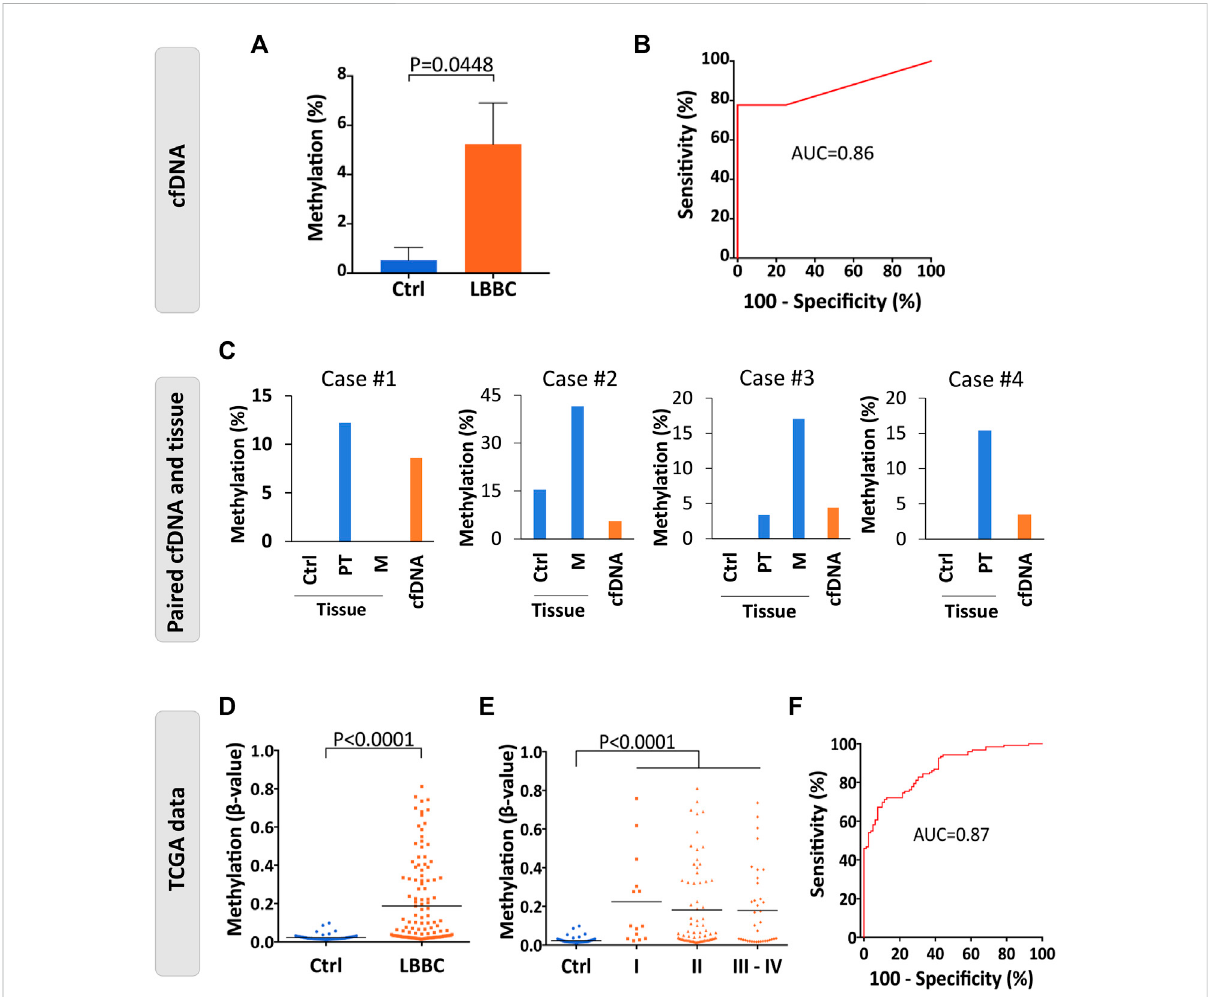
FIGURE 3 Methylation status of the WNT1 promoter in the cfDNA and tumor samples of patients with luminal B breast cancer. (A) Validation of the methylation levels of the WNT1 promoter (cg27196808) in cell-free DNA (cfDNA) of luminal B breast cancer patients ( n = 9) and nontumor controls ( n =4) analyzedbydropletdigital PCR(ddPCR). Methylationlevels arerepresented asthemean±SEM. (B) Diagnosticaccuracyofthemethylationof the WNT1 promoter using droplet digital PCR (ddPCR) in cfDNA for the detection of metastatic luminal B breast cancer patients ( n = 9) with respect to nontumor controls ( n = 4). (C) Methylation levels of WNT1 in cfDNA and paired breast primary and/or metastatic tumor samples of 4 luminal B breast cancer patients analyzed by droplet digital PCR (ddPCR). Nontumor tissues from the same patients were used as controls. (D – E) Methylation status of WNT1 in primary tumors of luminal B breast cancer patients ( n = 122) and nontumor controls ( n = 79) analyzed by 450K methylation arrayand obtained from TCGA considering (D) all TNM stages together (stages I – IV, n = 122) or (E) separated according to TNM stage (I, n = 14; II, n = 70; III-IV, n = 37). The horizontal line represents the mean methylation values. (F) ROC curve evaluating the methylation of WNT1 to detectprimarytumorsofluminalBbreastcancerpatients(stagesI-IV, n =122)withrespecttonontumorcontrols( n